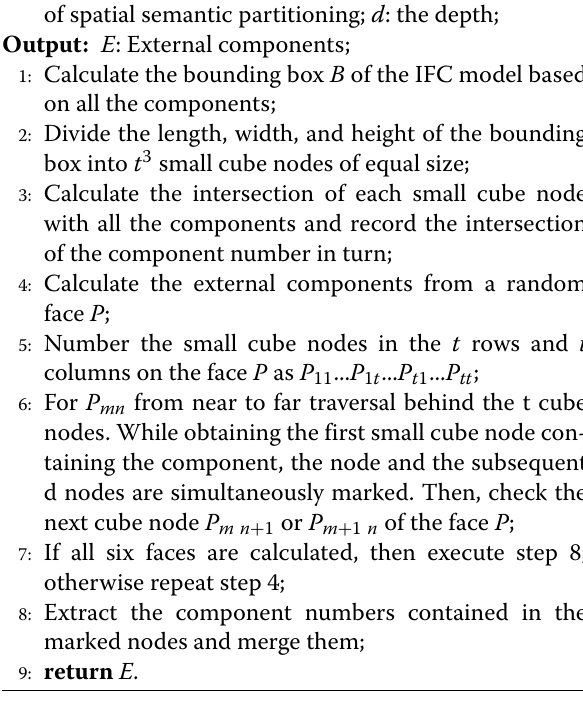
from near to far. Subsequently, if the component does not cover the previously covered area, then it is added into